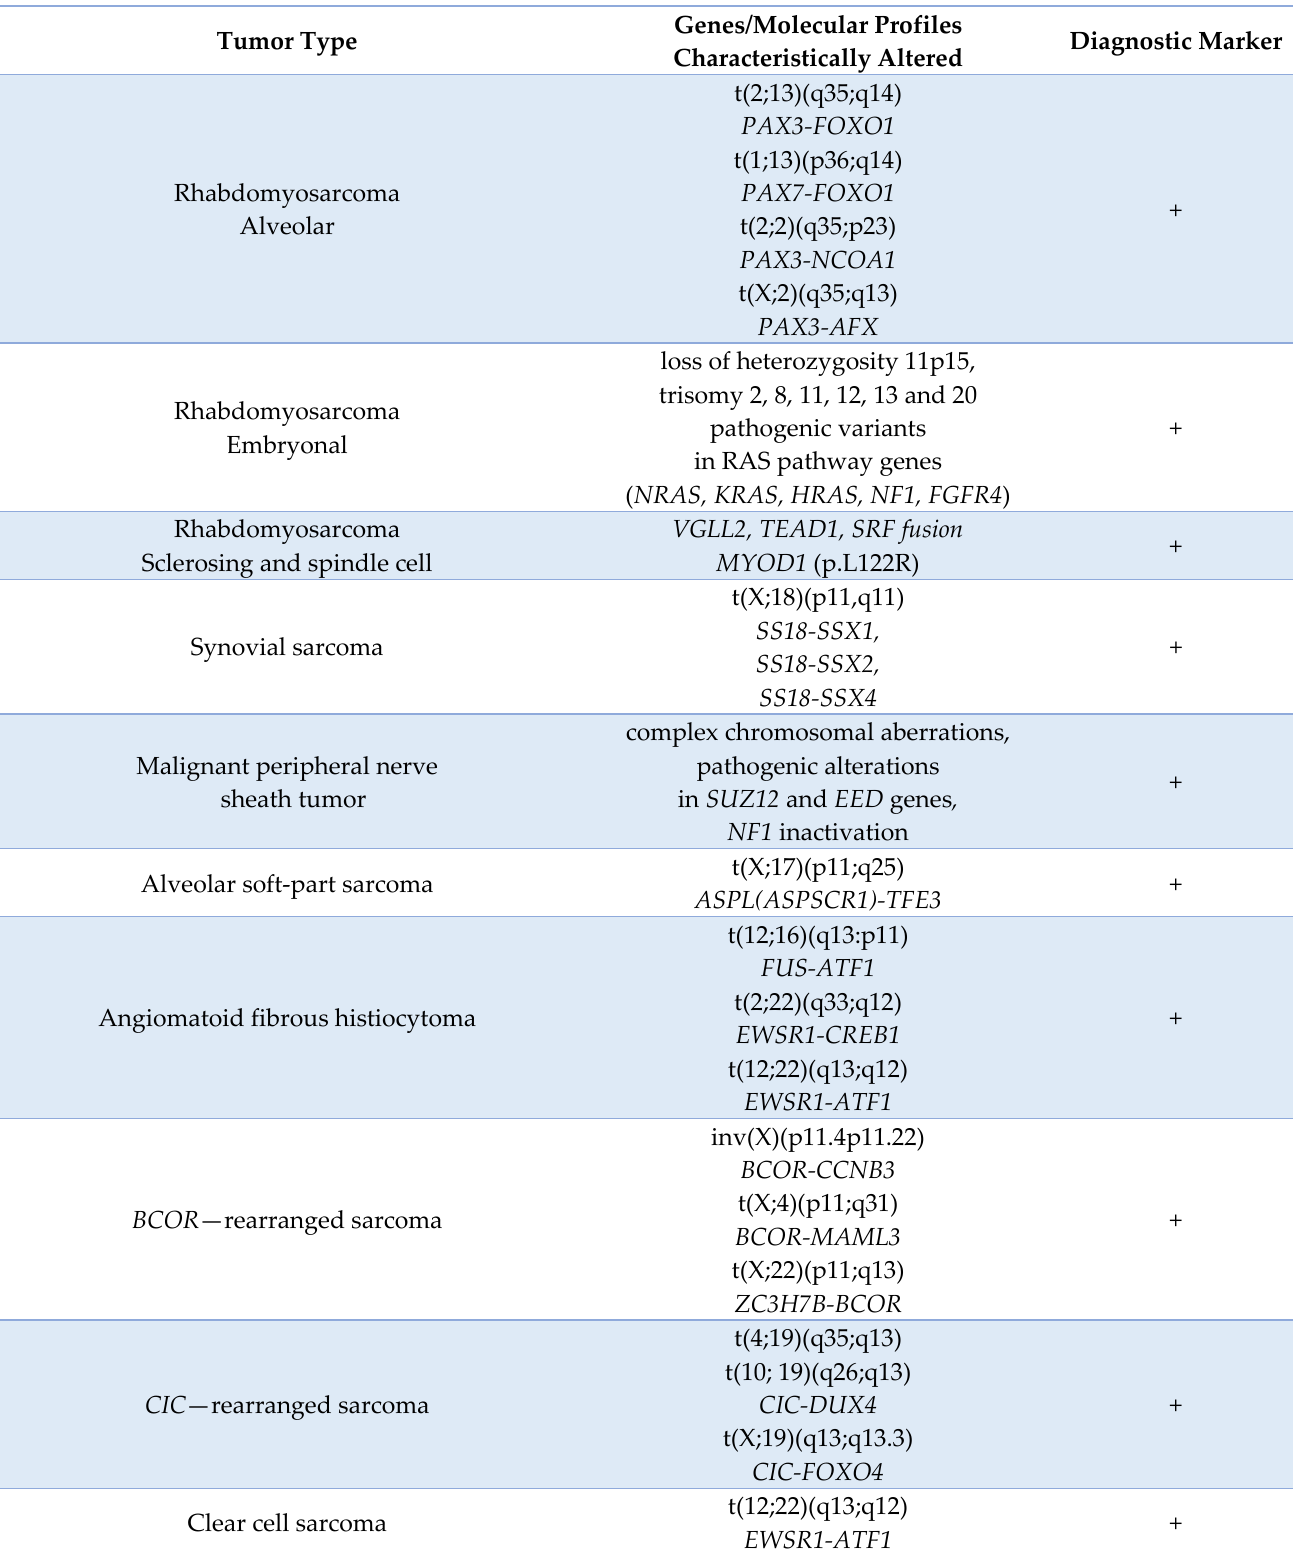
Table 5. Molecular markers—soft tissue sarcomas.